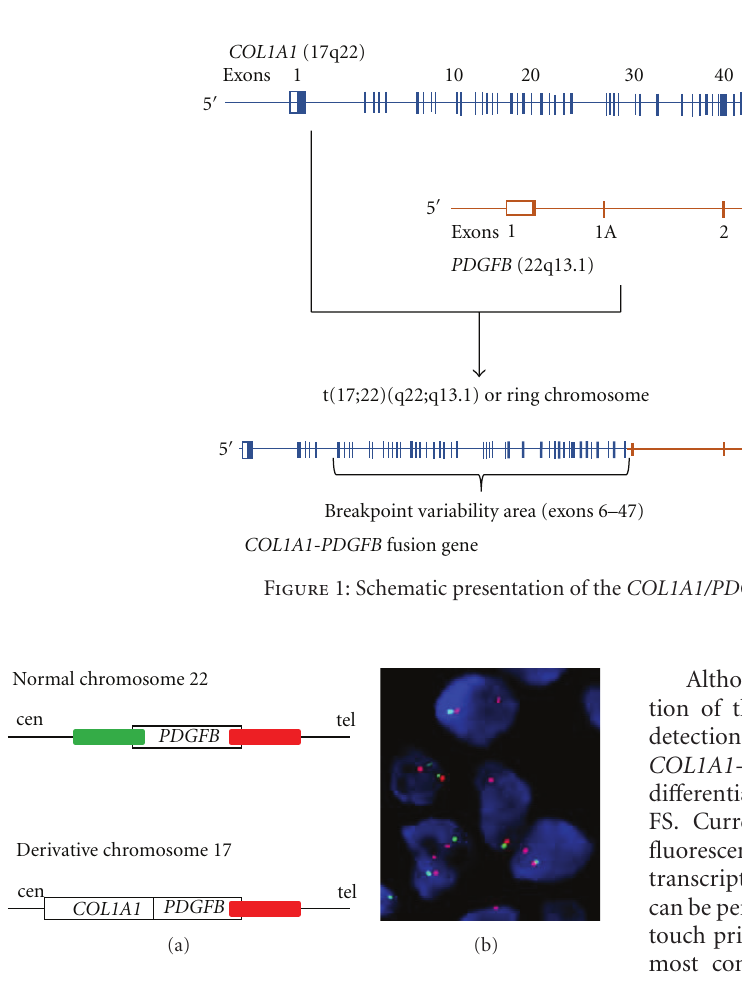
Figure 2: PDGFB break-apart FISH in interphase nuclei from DFSP. (a) Schematic localization of FISH probes; (b) PDGFB rearrangement detected by FISH, evidenced by one copy (red probe) of the telomeric PDGFB signal in tumor cells (courtesy of Professor M.